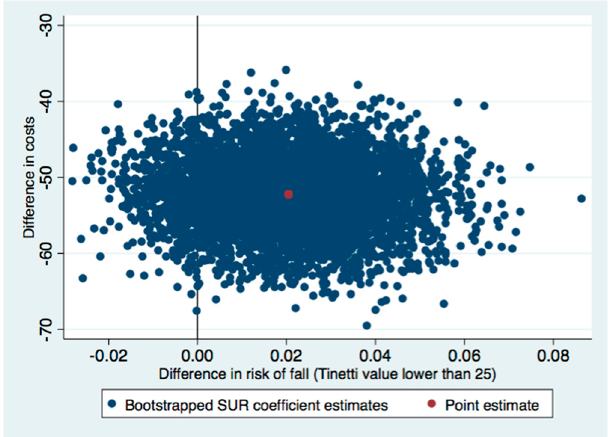
Figure 2. Cost-effectiveness plane for risk of fall using the Tinetti instrument. SUR: seemingly unrelated regression.